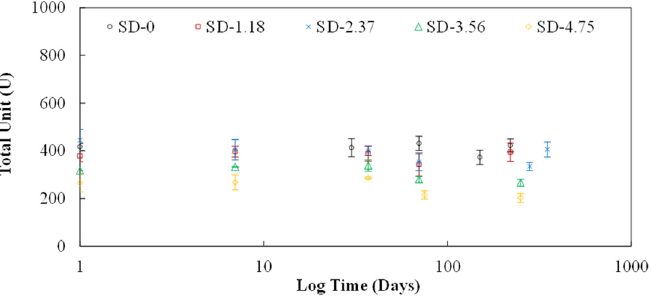
Figure 8. Urease activity measurement in total units for different concentrations (0%, 1.18%, 2.37%, 3.56%, and 4.75%) of sucrose and dextran (SD) added during lyophilization of crude extract after rehydration and storage at different times at RT.